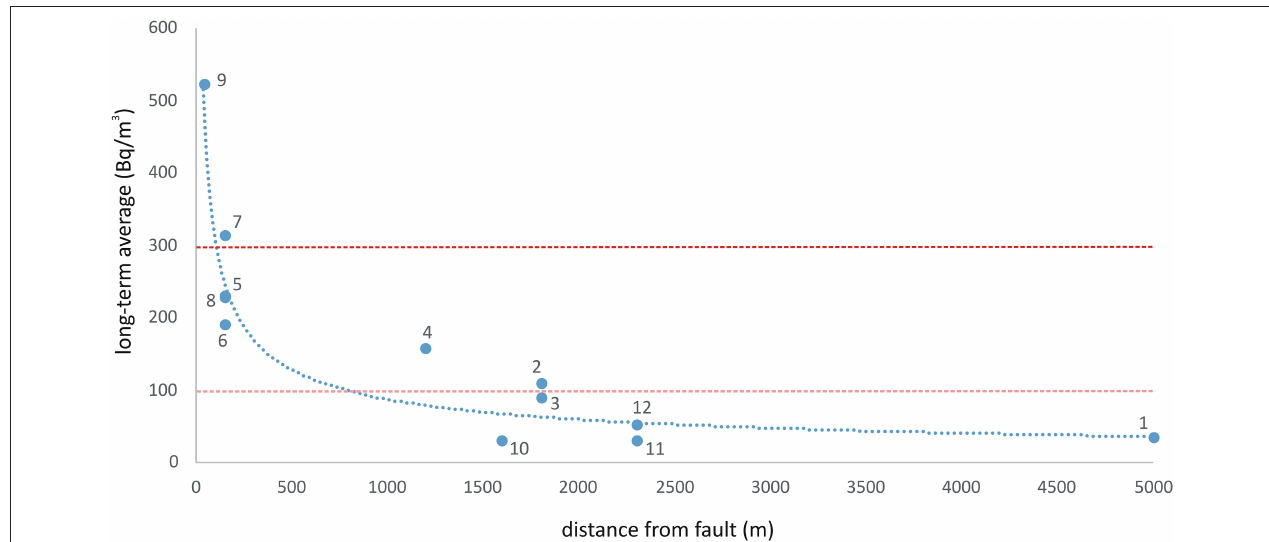
FIGURE 9 | Correlation between long-term average radon and distance from known active faults. Sites 7 and 9 showed radon activities that exceeded the maximum threshold (300 Bq/m 3 ) recommended by the WHO handbook (33) - represented by the red dashed line. The pink dotted line indicates the limit of 100 Bq/m 3 recommended as the attention threshold by the WHO. The dotted blue line represents the best-fit model to the data (following a power law: y = 3,928 × − 0.551 , with R 2 =